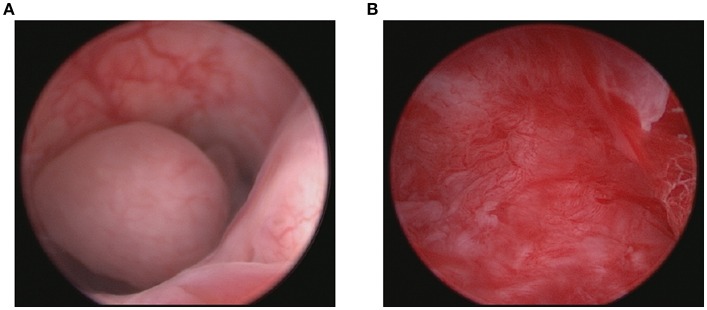
Tumor before resection (A) and the cavity after tumor resection (B) during the hysteroscopy.